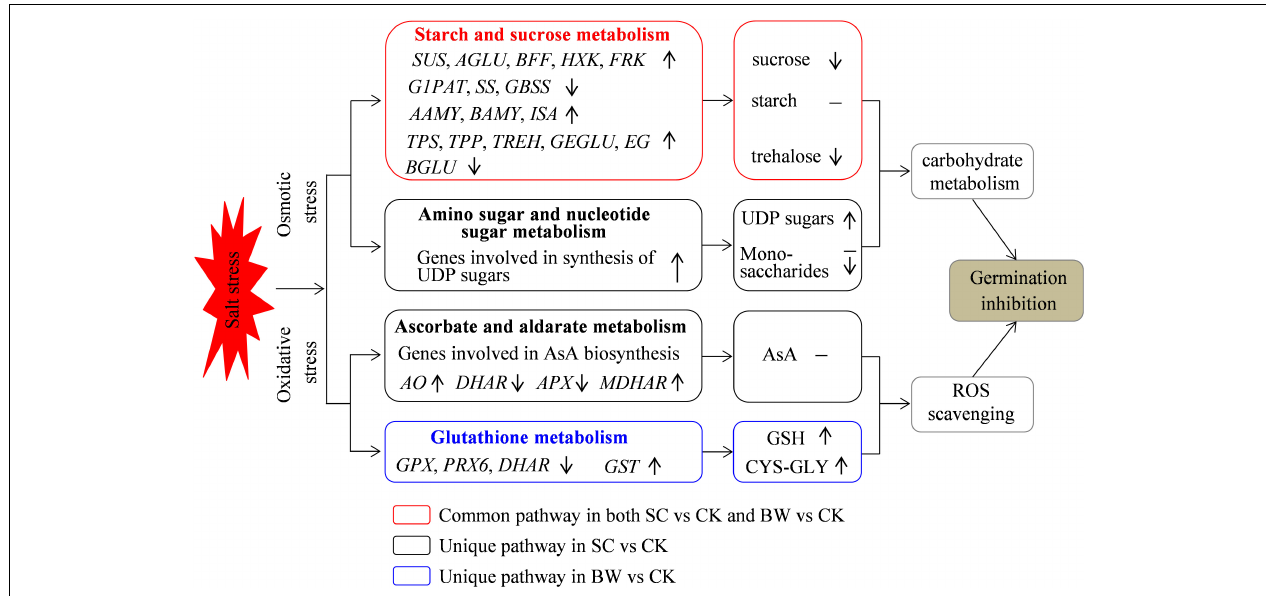
FIGURE 7 | A proposed model for germination inhibition at the seed initial imbibition stage under salt stress. Osmotic stress and oxidative stress were induced and some related DEGs were regulated under SC and BW stresses during seed germination.